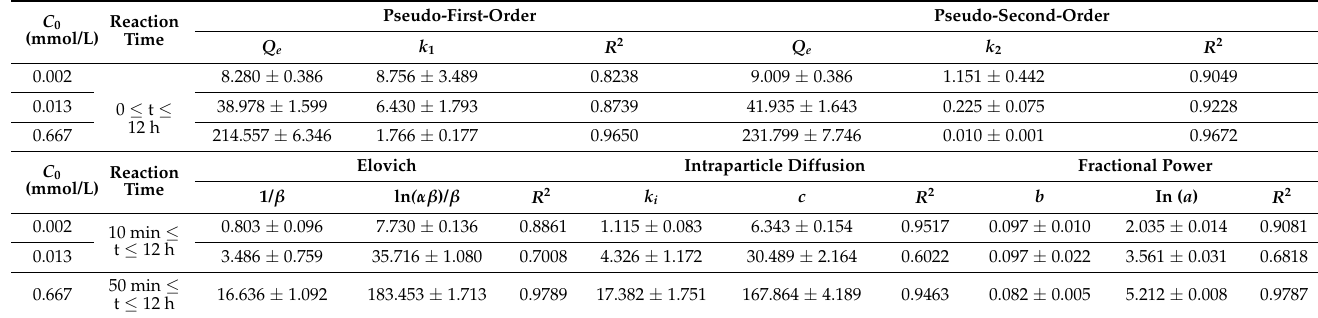
Table 2. Parameters of five kinetic models for MTAs V adsorption on the